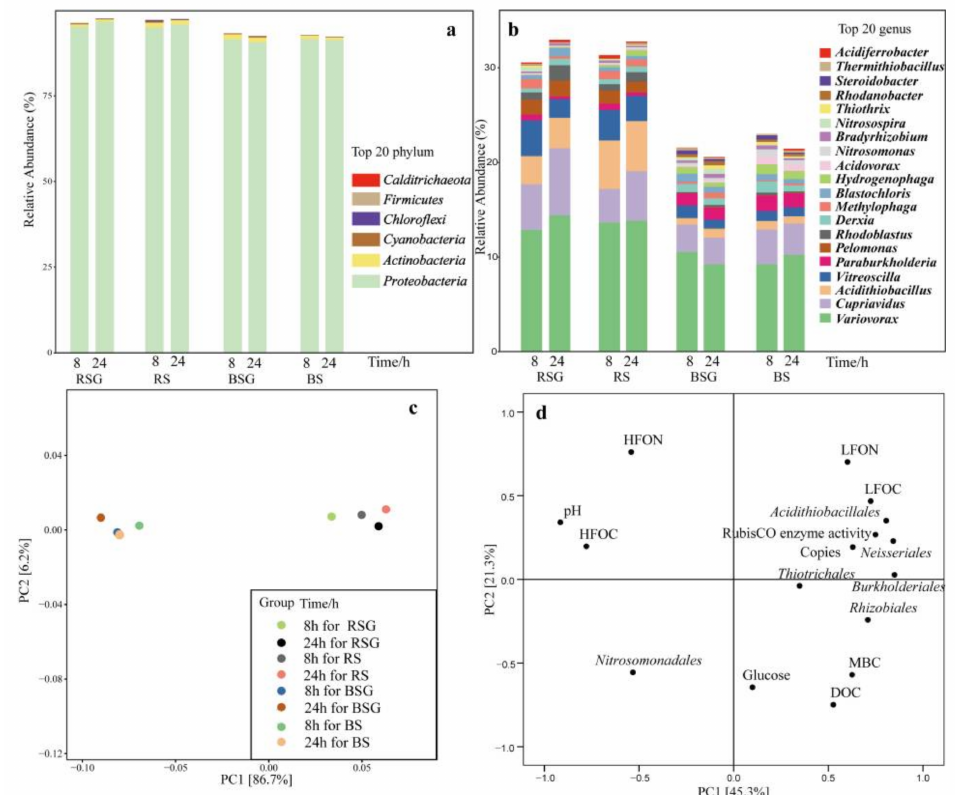
Figure 6. Composition of cbbL -containing bacteria at the phylum ( a ) and genus ( b ) levels. Principal component analysis (PCA) of the variables based on the genus composition ( c ) and PCA of main orders and soil properties ( d